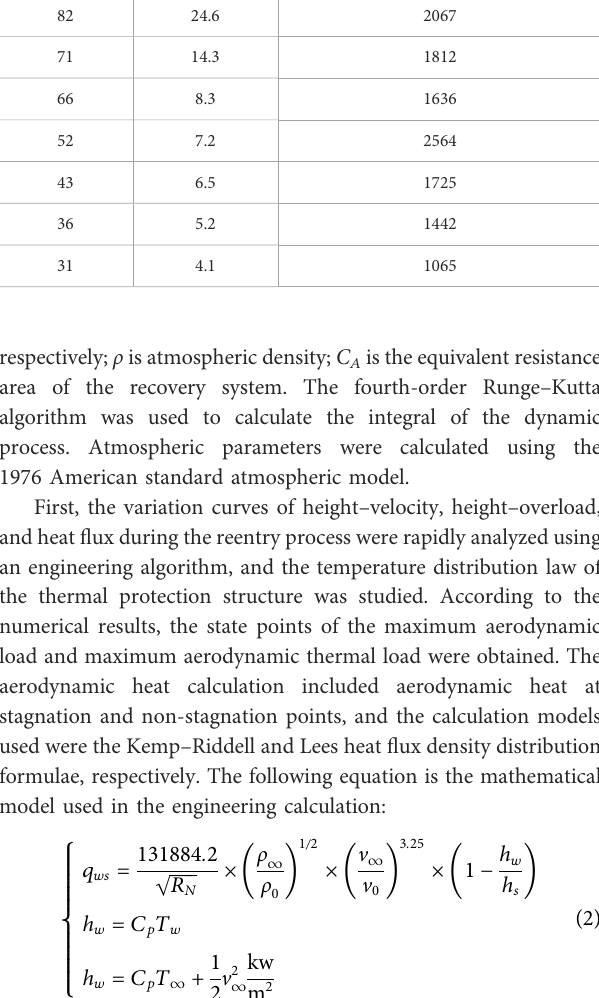
TABLE 2 Stagnation point temperature and heat fl ux at different altitudes and Mach numbers. Height (m) Velocity Stagnation points (Ma) temperature